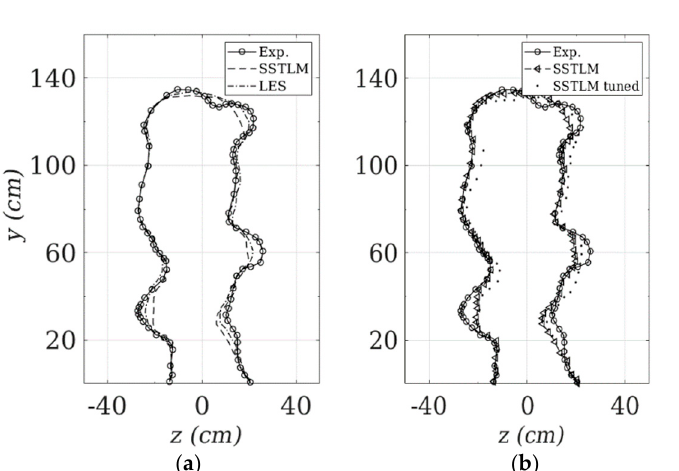
Figure 3. Contour of 0.9 U ∞ for different meshes and turbulence modeling approaches in a yz -plane at 0.8m behind the rear wheel, compared with the experimental data from Terra et al. [8]: ( a ) LES vs. SSTLM; ( b ) SSTLM vs. Tuned